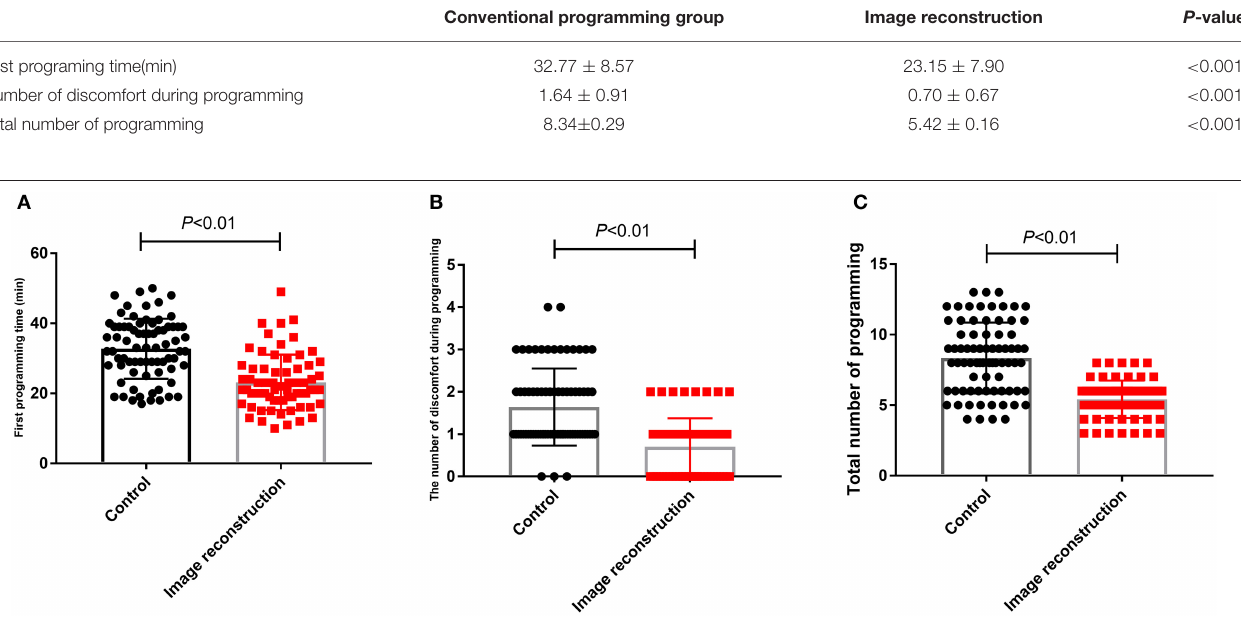
TABLE 3 | Comparison of first programing time, number of discomfort during programming between conventional programming group and image reconstruction group.